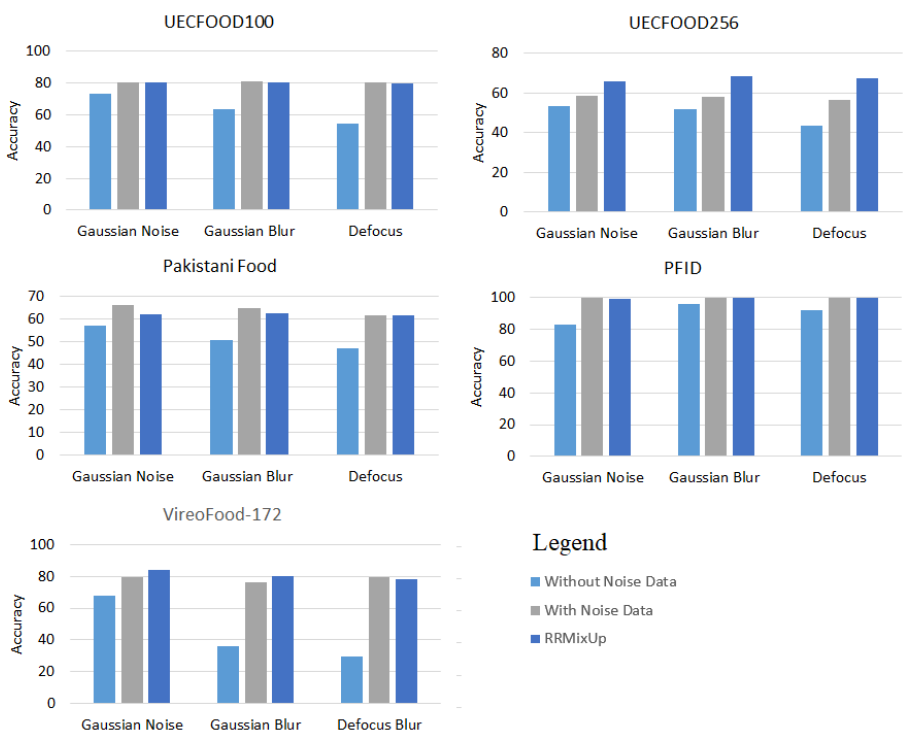
Figure 11. Proposed data augmentation strategy RIMixUp during fine-tuning improves the robust- ness of the